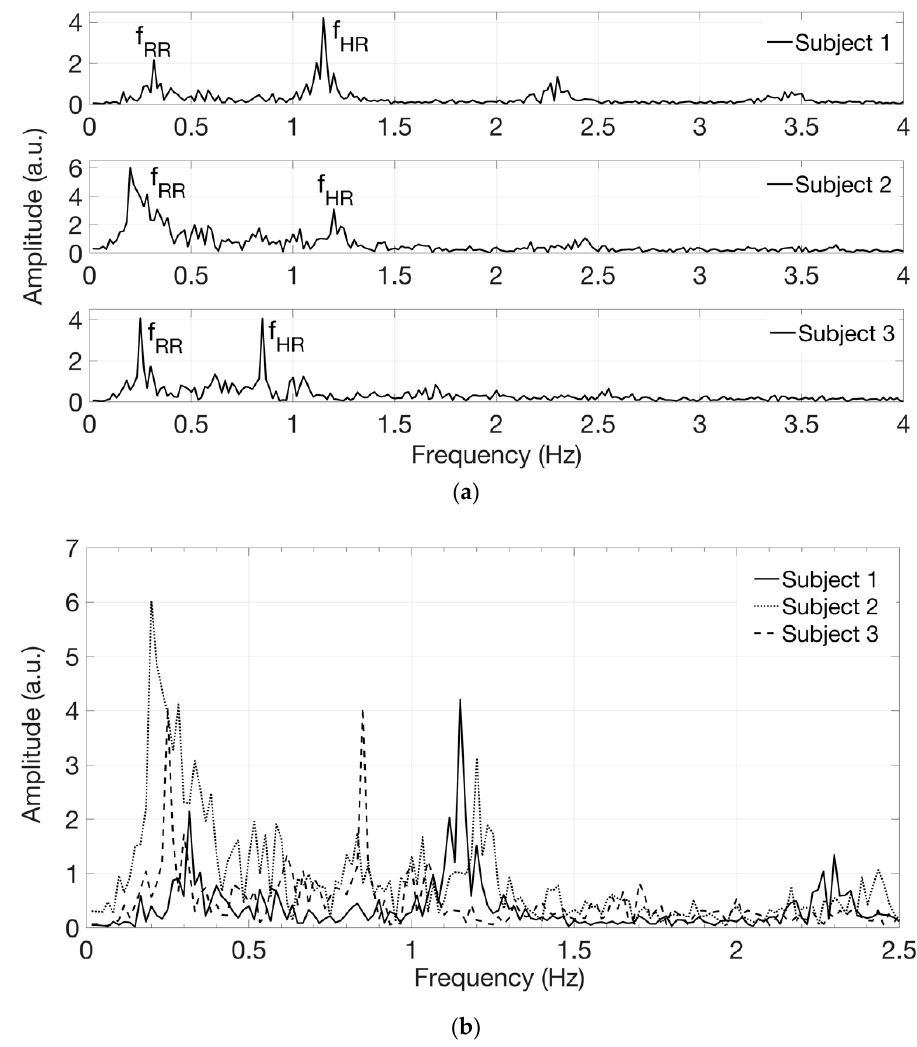
Figure 6. Signals in the frequency domain extracted from the acquired videos on white-skin, female subjects 1, 2 and 3. ( a ) Spectra are reported in separate graphs for each subject; ( b ) Spectra are superimposed for comparison, on a narrower frequency range.